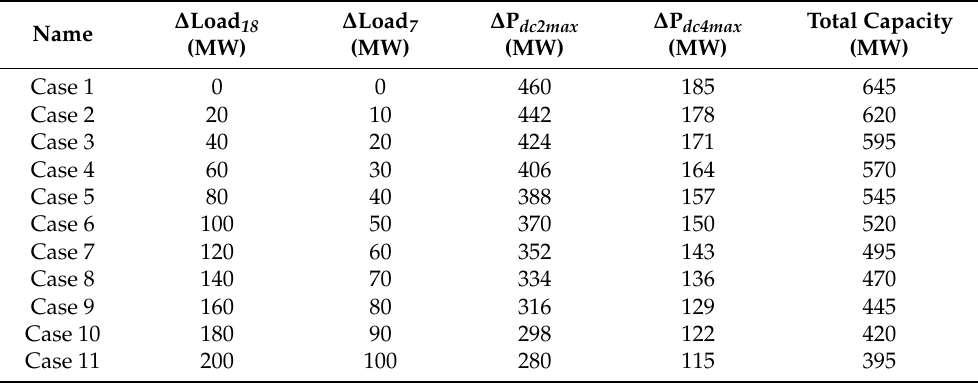
Table 5. Load variation on the maximum regulation capacity of the APC